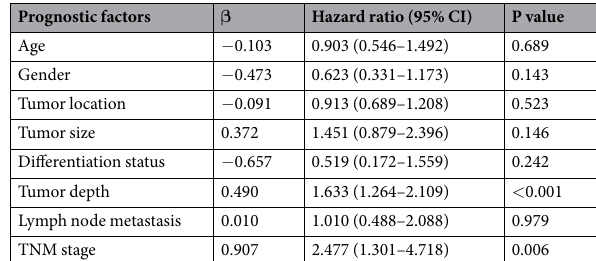
Table 2. Risk factors for OS of gastric ASC patients according to univariate analysis (n = 109).